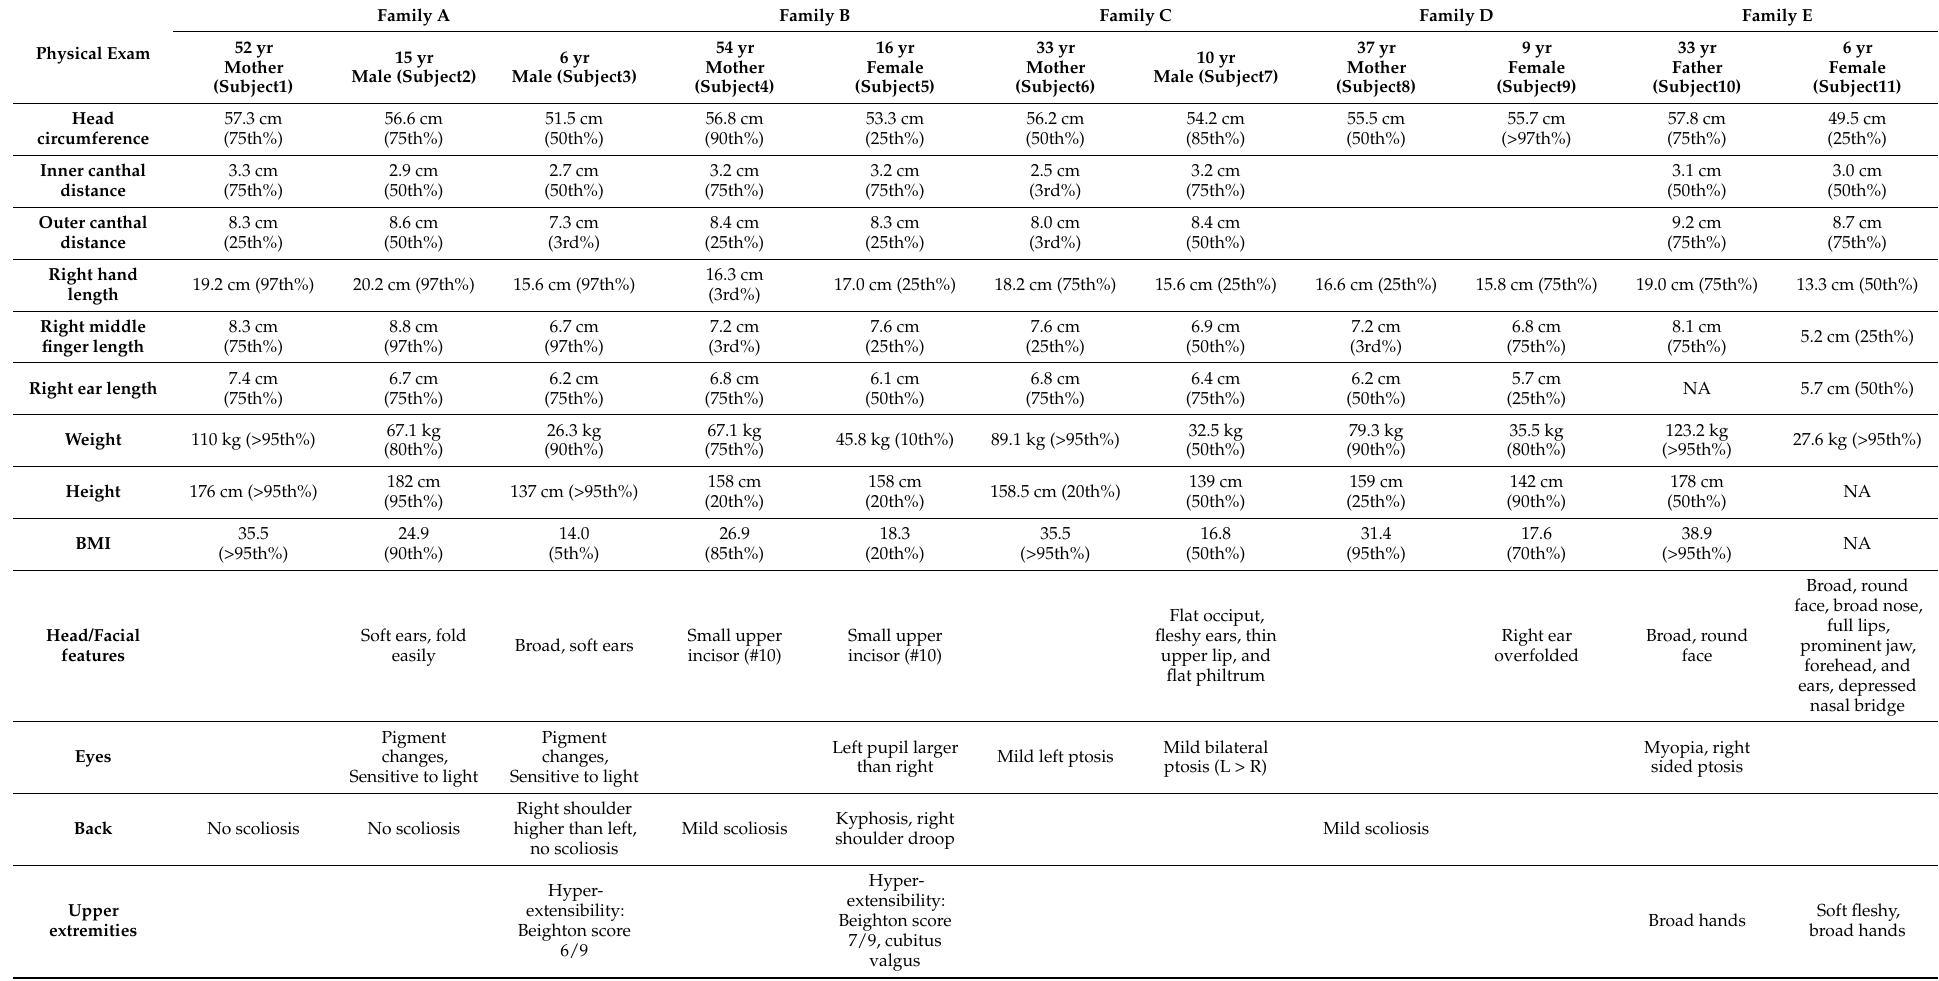
Table 5. Specific clinical evaluation and physical exam findings of families with 15q11.2 BP1-BP2